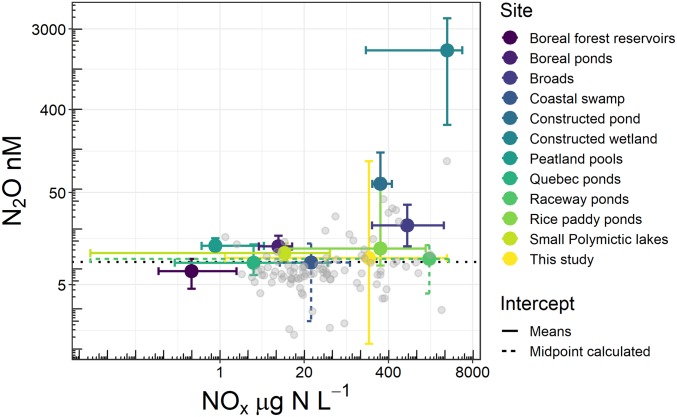
Range of N2O and NOx concentrations measured in small lentic systems. Error bars represent upper and lower ranges in each dataset. The concentration of N2O at equilibrium is represented by the dotted line. Gray circles are individual reservoirs from our study. See SI Appendix for full references.